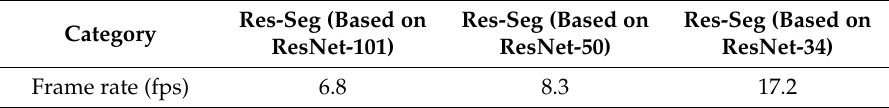
Table 4. Time cost of Res-Seg network testing at di ff erent